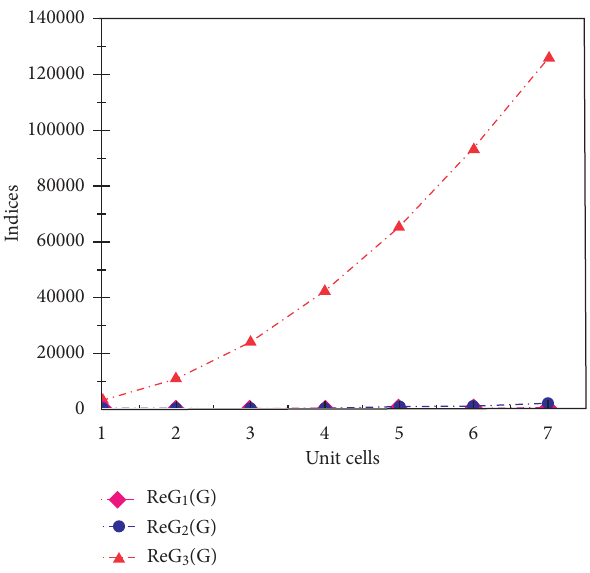
Figure 5: Comparison of Re G Table 6: Values of heat of formation and entropy for different formula units of TbO